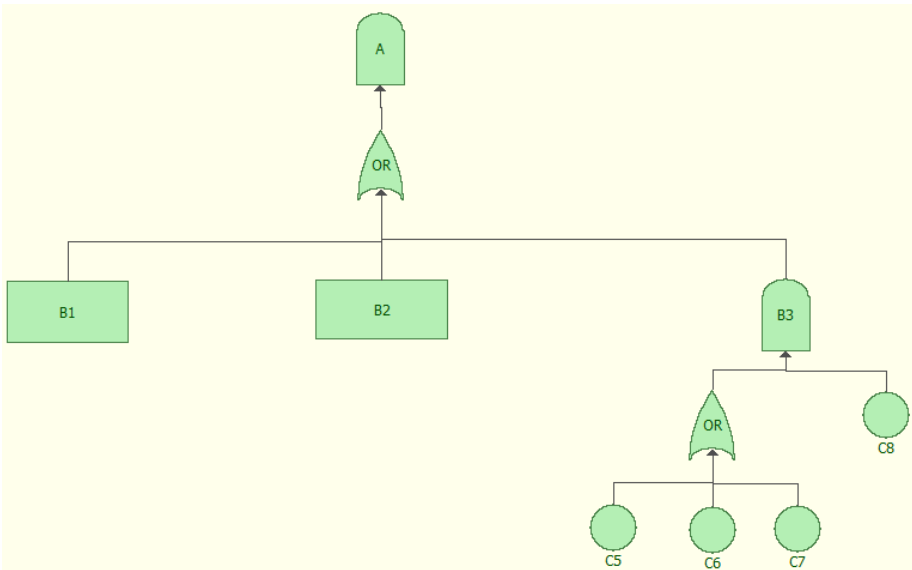
Figure 5. Data transmission, second level fault tree